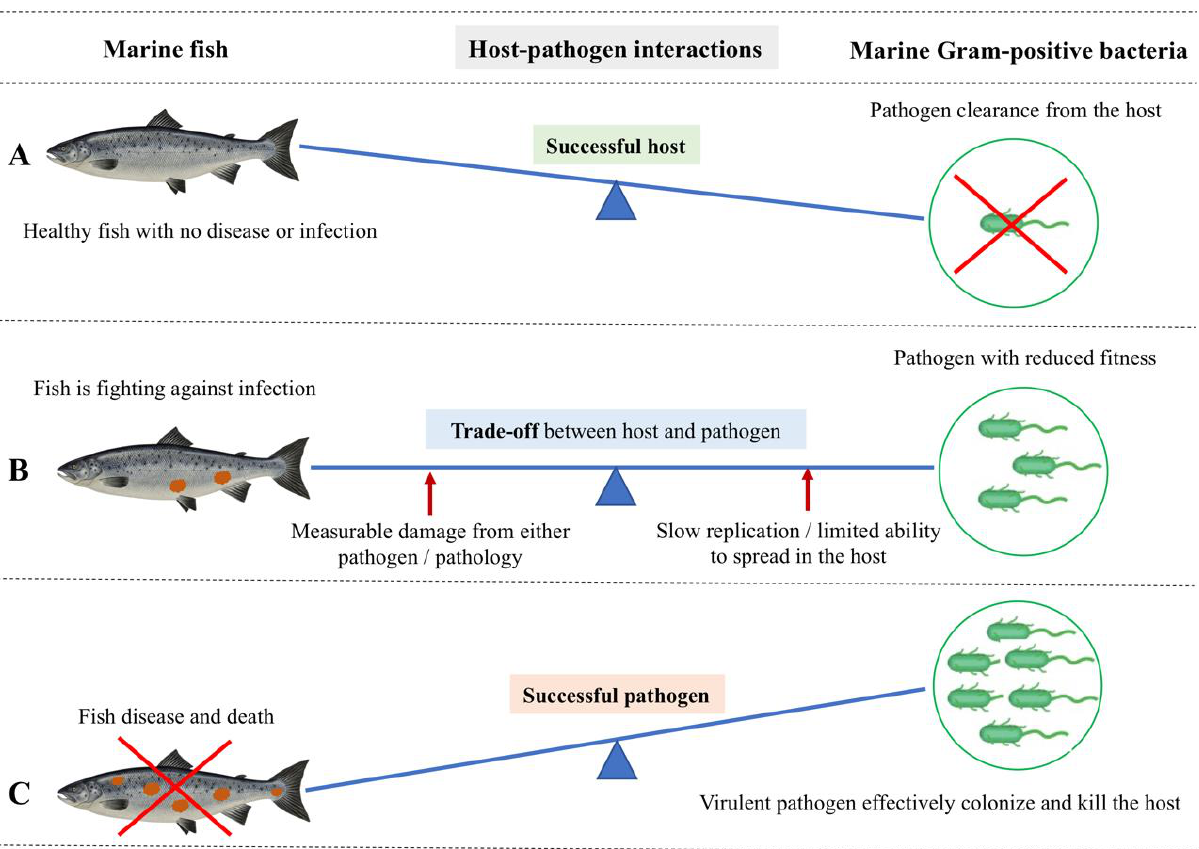
Figure 2. Host-centric and pathogen-centric views of dynamic host-pathogen interactions between marine Gram-positive bacteria and a marine fish host. ( A ) Successful host: Fish show no disease or infection because of successful pathogen clearance by the host- induced pathogen-specific immune response. Therefore, fish stay healthy, with effective immunological and physiological homeo- stasis upon an infection event. ( B ) The trade-off between host and pathogen: It is the actual tug-of-war scenario between the fish host and pathogen. Here, the fish is still alive but fighting against the infection with an initiated specific immune response. In this trade- off, the pathogen compromises its fitness, thereby slowly replicating without alerting the fish immune response and exploiting the fish host without killing it. On the other hand, the fish is measurably damaged as a result of either the pathogen’s action or a host- specific pathology. There is a scenario where increased acquisition and allocation of nutrients occur at the host/pathogen nutritional